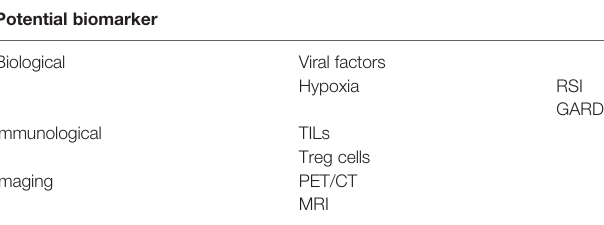
TABLE 1 | Overview on the main points described in the review. Potential